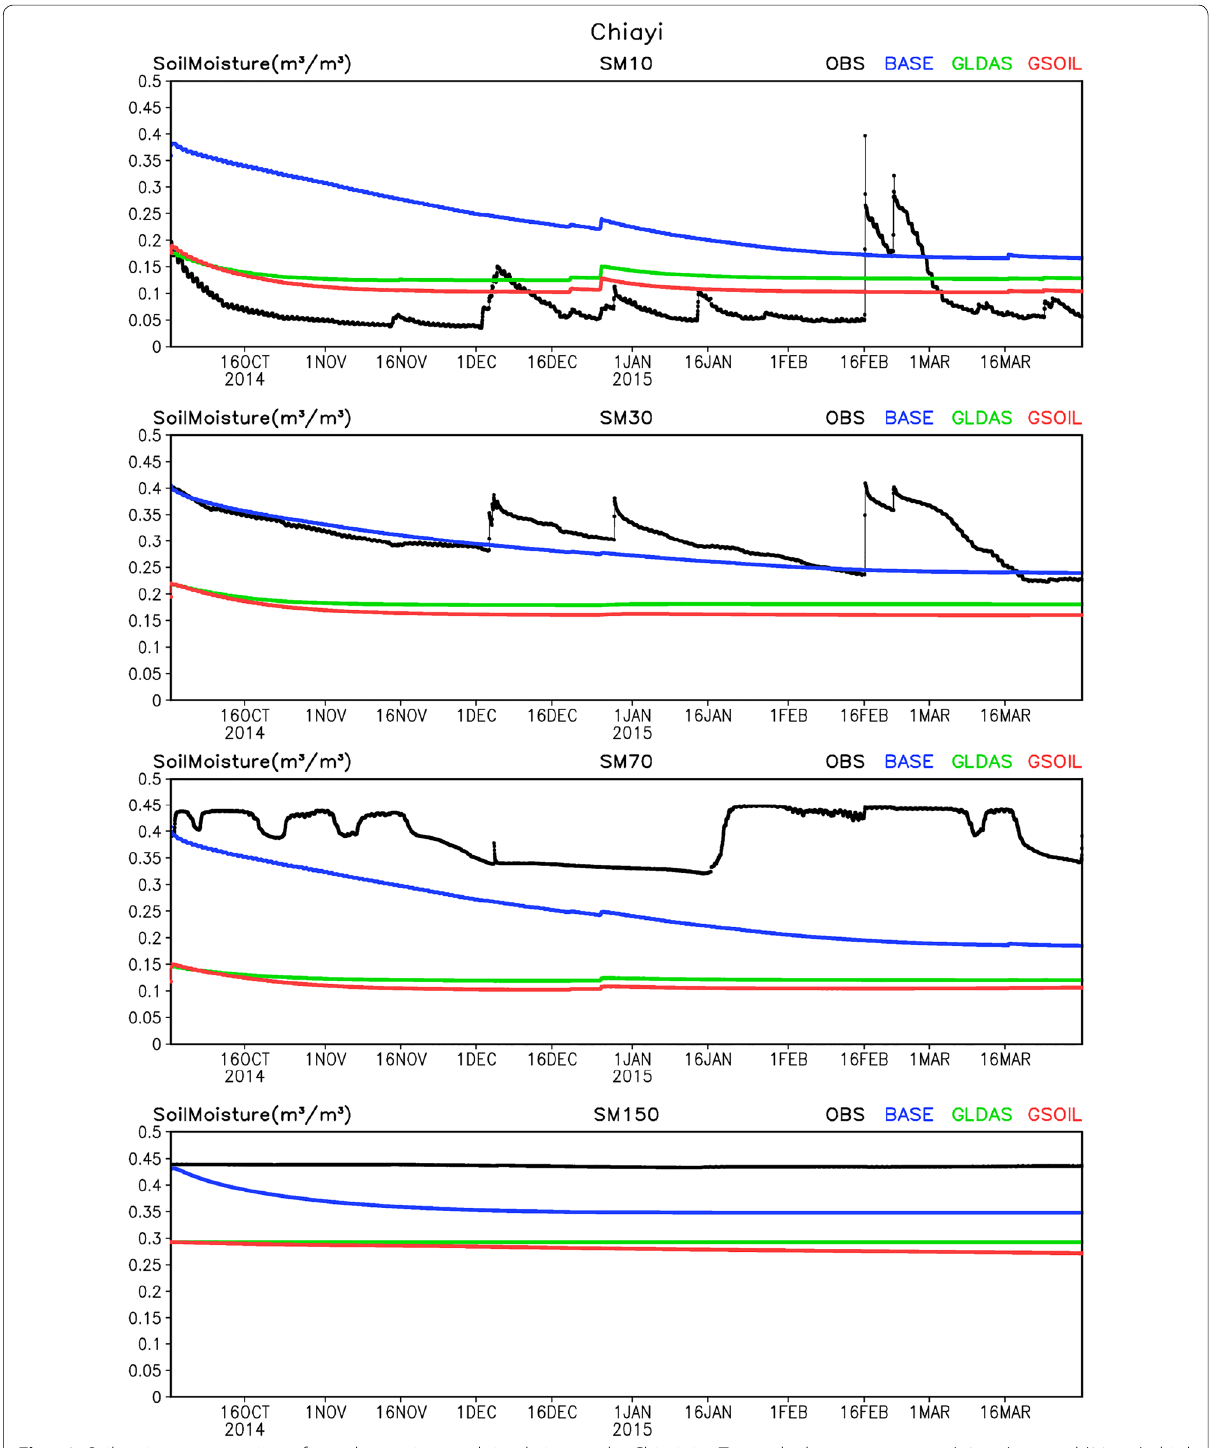
Fig. 10 Soil moisture comparisons from observations and simulations at the Chiayi site. Top to the bottom are at top (10‑cm), second (30‑cm), third (70‑cm), and fourth (150‑cm) soil layer (black: observation; blue: WRF‑base; green: WRF‑GLDAS; red: